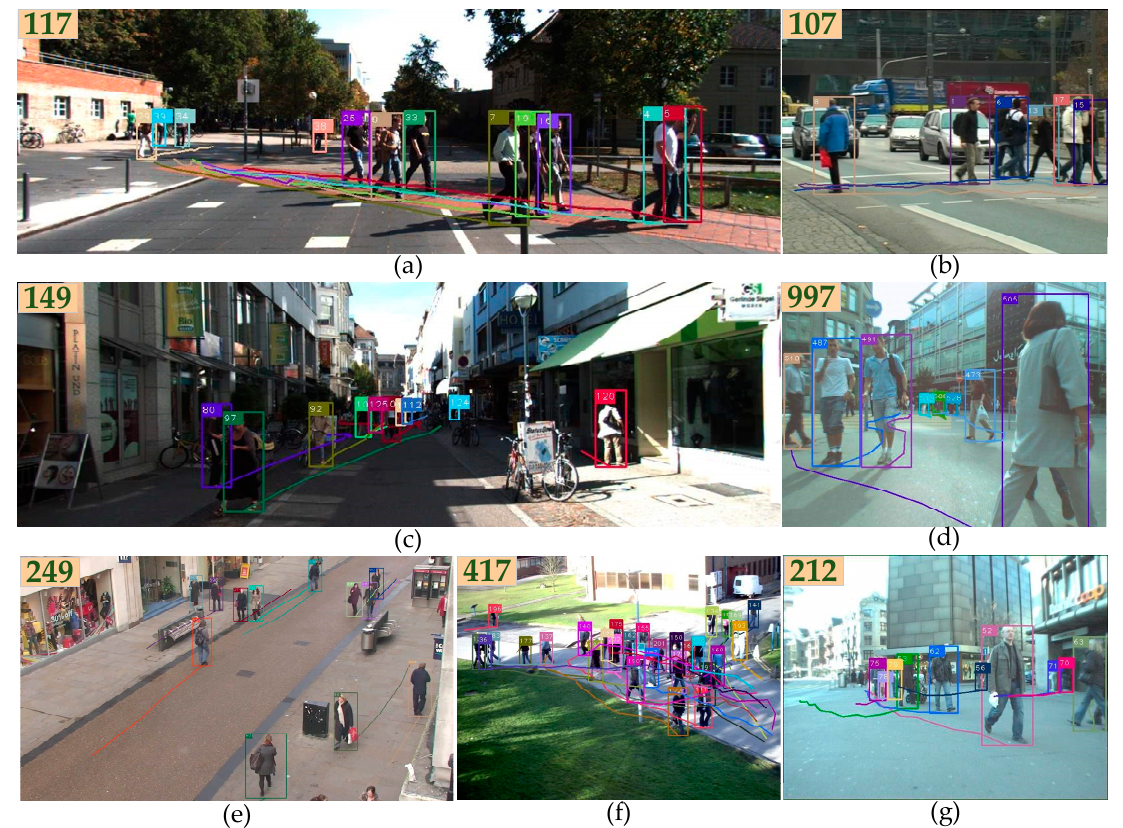
Figure 8. Tracking results of SORT-YM on MOT-15 dataset. The number in the upper left corner represents the frame number of the image. ( a ) KITTI-16. ( b ) TUD-Crossing. ( c ) KITTI-19. ( d ) ETH-Linthescher. ( e ) AVG-TownCenter. ( f ) PETS09-S2L2. ( g ) ETH-Jelmoli.